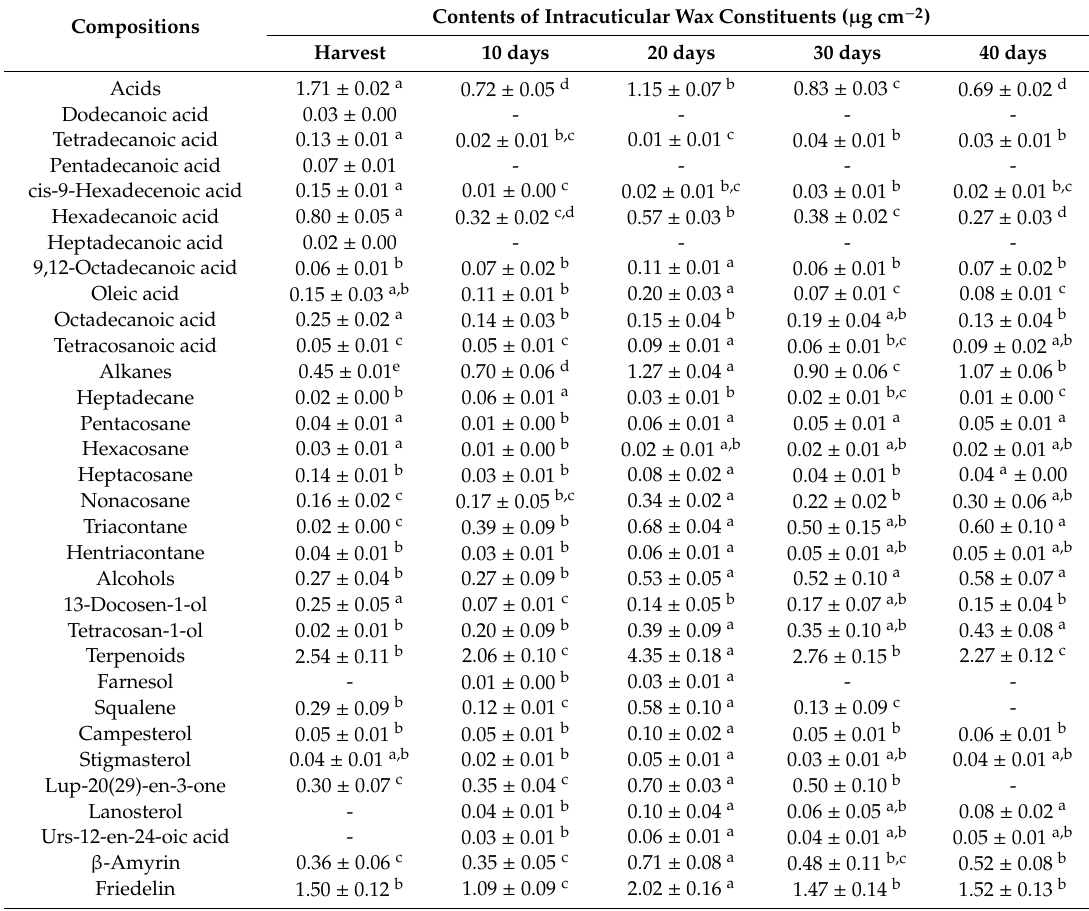
Table 3. Intracuticular wax main constituents of ‘Satsuma’ mandarin fruits during